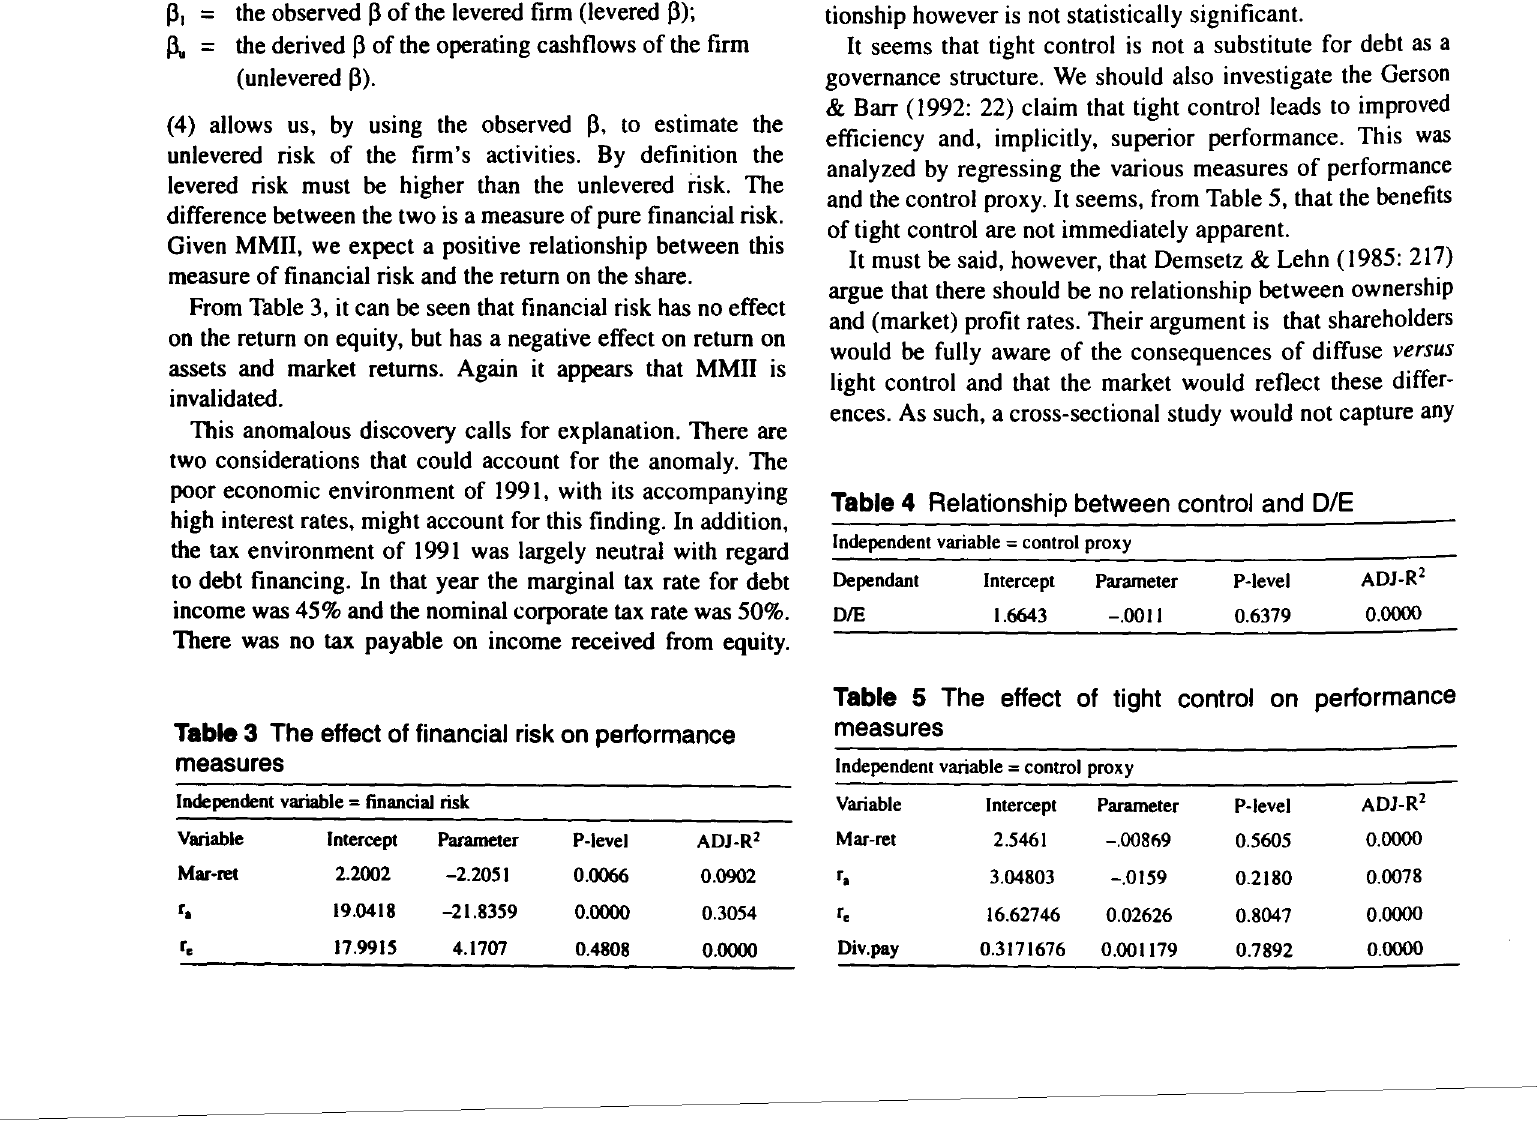
Table 5 The effect of tight control on